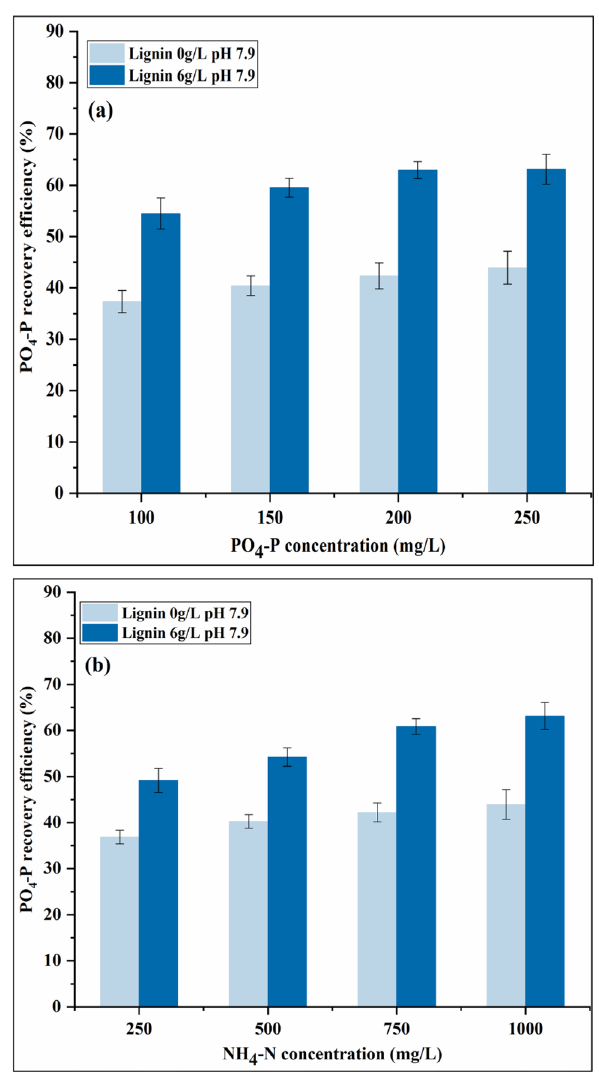
Figure 1. Impact of initial ( a ) PO 4 –P concentration (Mg/P molar ratio = 1.5, [NH 4 –N] = 1000 mg/L) and ( b ) NH 4 –N concentration (Mg/P molar ratio = 1.5, [PO 4 –P] = 250 mg/L) on PO 4 –P recovery efficiency at pH